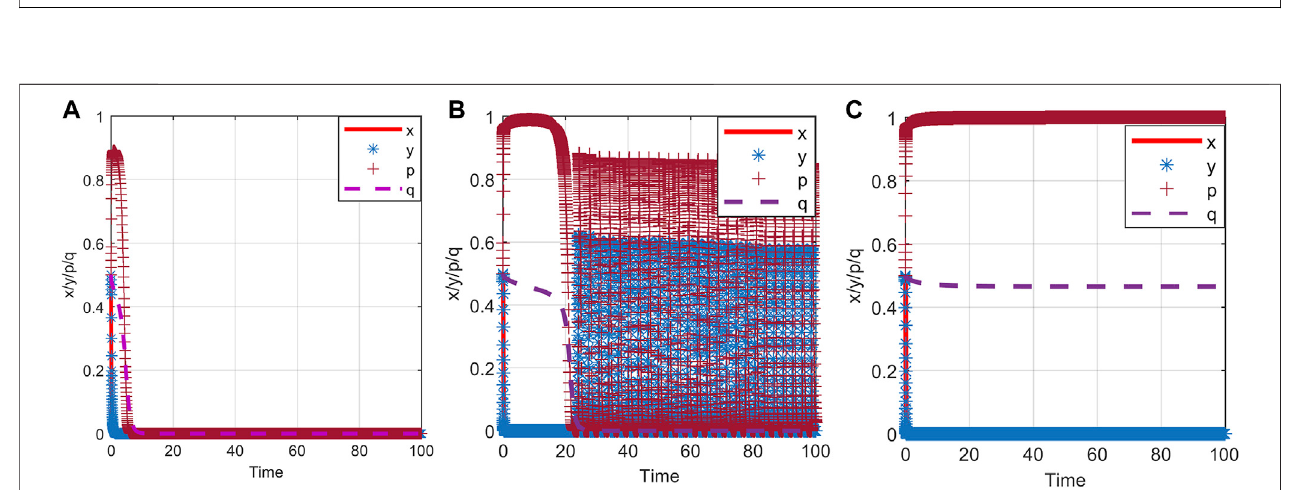
FIGURE 7 | The impact of reward and penalty. (A) when the situation is (0, 0). (B) when the situation is (30, 30). (C) when the situation is (60, 60).